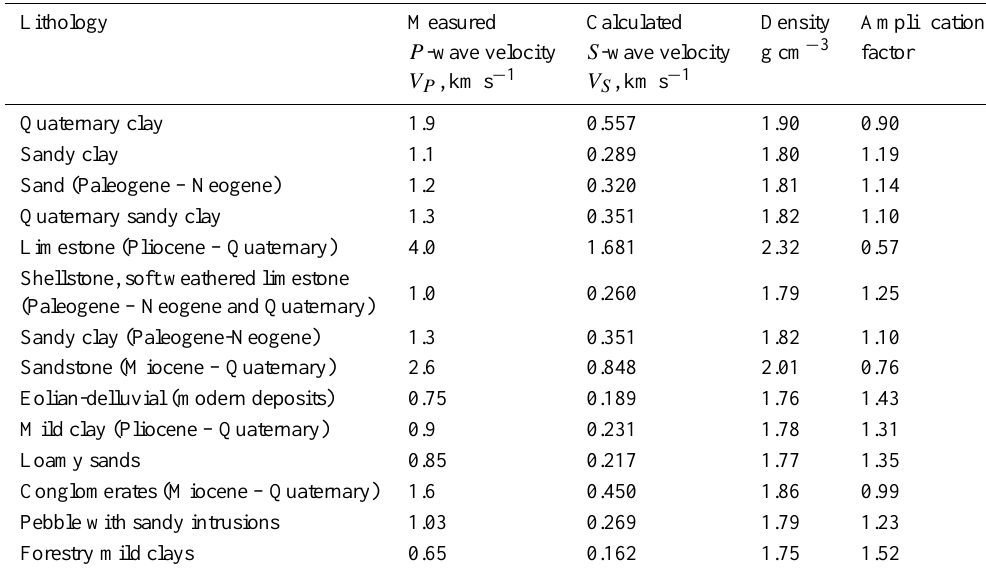
Table 3. Physical parameters of the principal soil units in the Absheron peninsula. Lithology